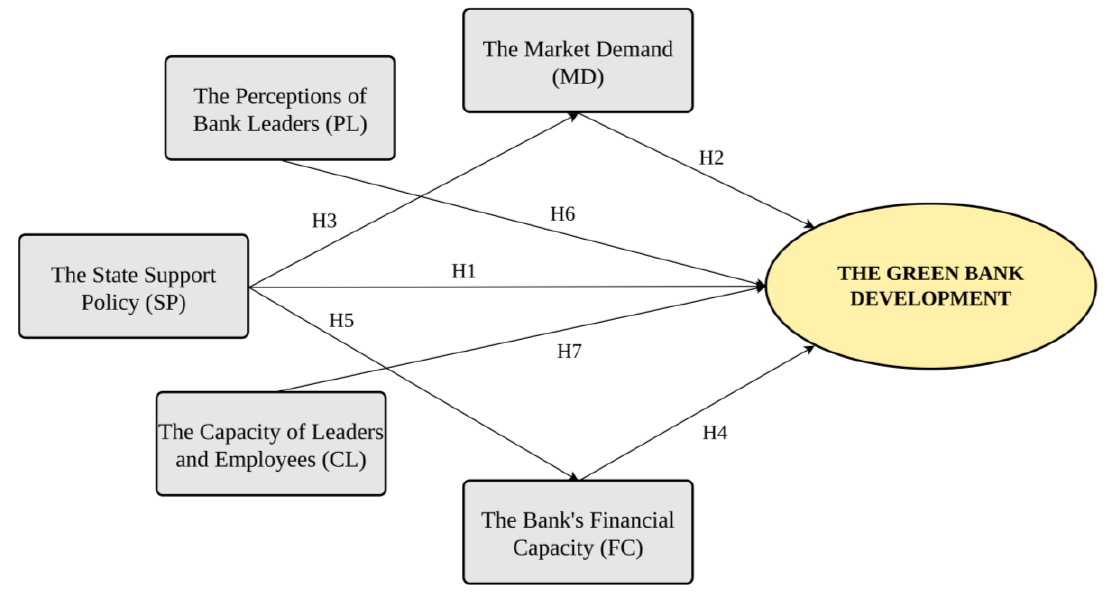
Figure 1. The research model for the factors affecting the green bank development